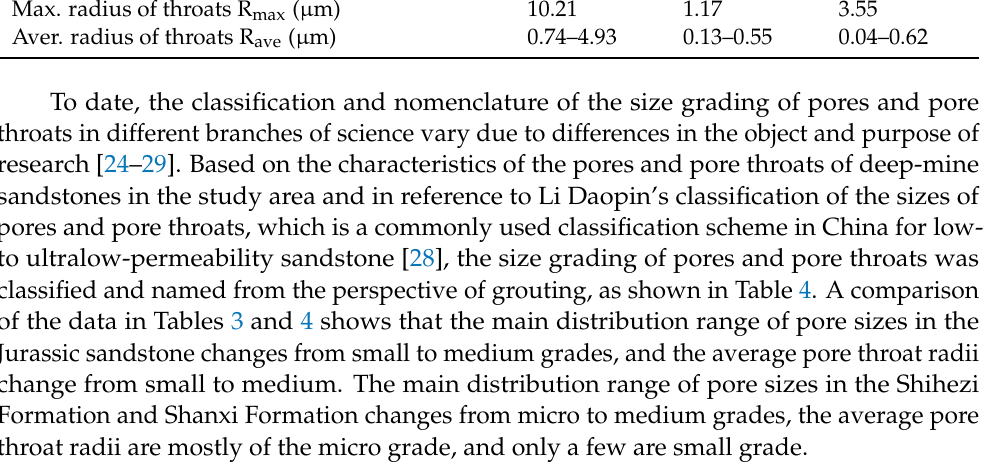
Table 3. Sizes of pores and pore throats in deep-mine sandstone. Sizes of Pores and Pore Throats Max. visual diameter of pores D ( µ m) 150 150 250 Main distribution range of pores size D ( µ m) 10–50 1–50 1–50 Max. radius of throats R max ( µ m)